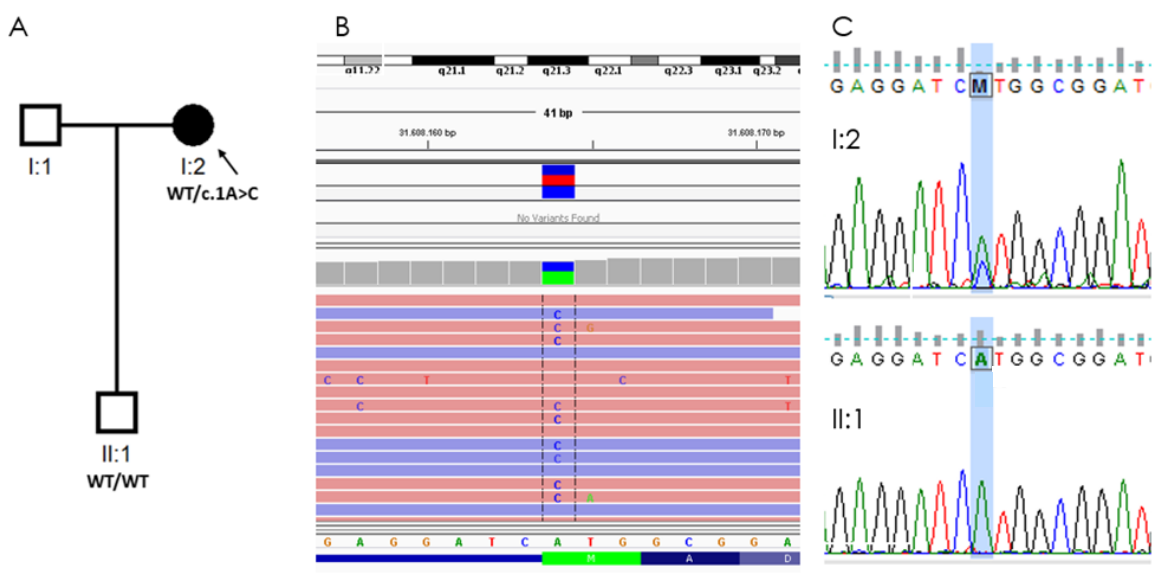
Figure 3. Genetic findings in a woman with PPCD and keratoconus and her healthy son. ( A ) Pedi- gree of the family, individual I:2 carries the loss-of-function (LoF) ZEB1 mutation: NM_030751.6:c.1A > C (p.Met1Leu). ( B ) NM_030751.6:c.1A > C (p.Met1Leu) was detected in